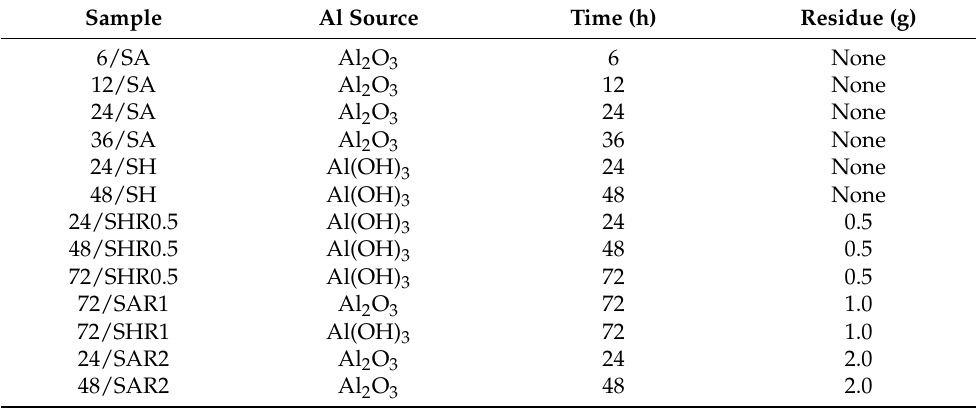
Table 1. Parameters related to the aluminum source, synthesis time, and residue mass used in the synthesis of SAPO-11 materials and respective